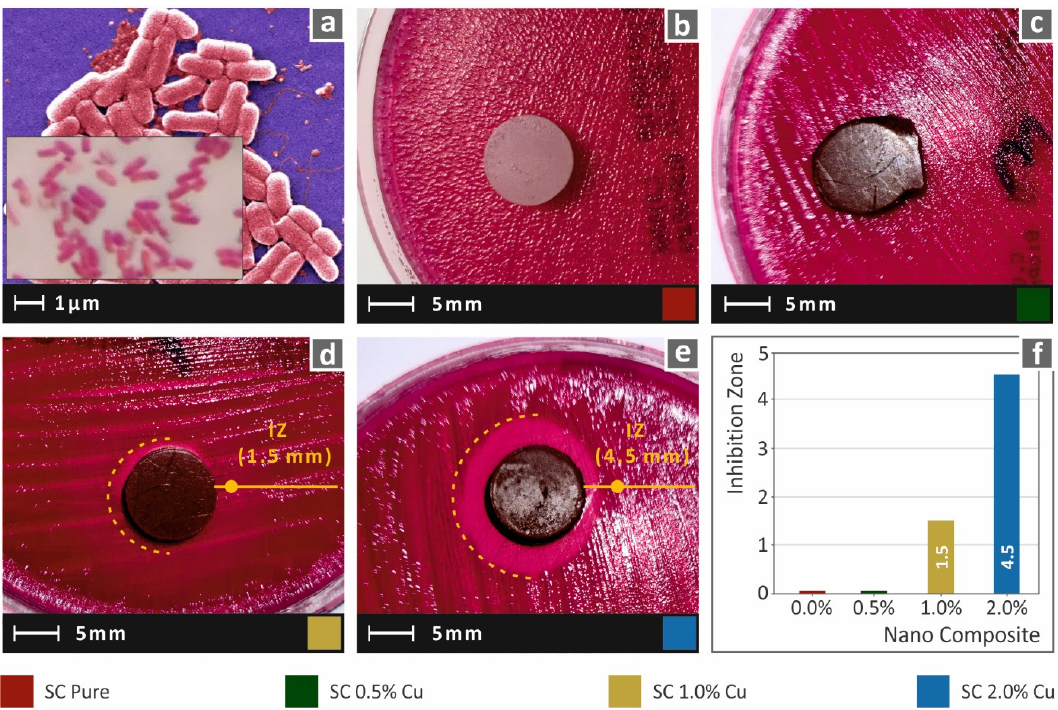
Figure 12. ( a ) typical E. Coli morphology, ( b – e ) Vertical captures after 24 h cultivation of tested specimen in Petri dish for each corresponding tested material, ( f ) Comparative graph of the measured inhibition zones to filler loading (wt.%).